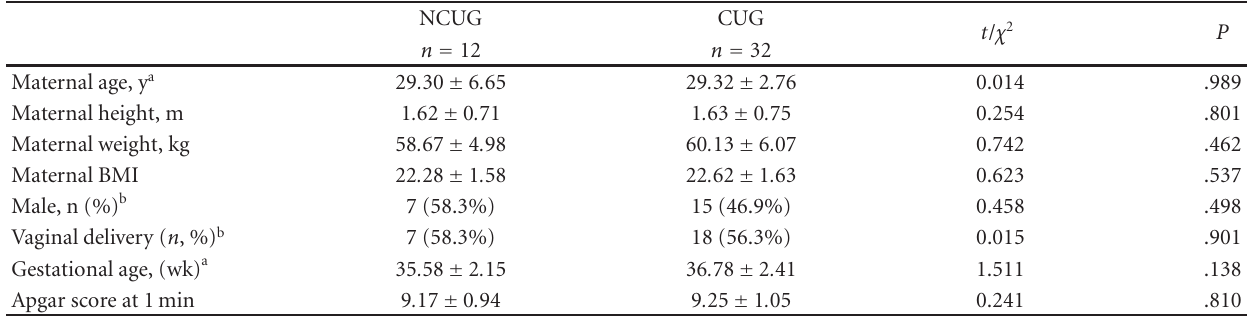
Table 1: Comparisons of demographic characteristics between NCUG and CUG groups.